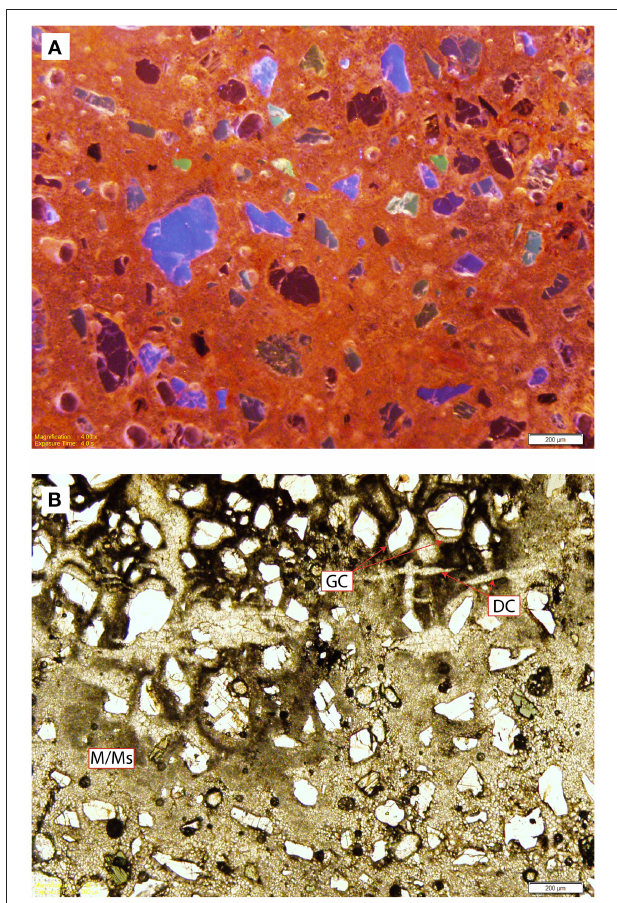
FIGURE 10 | Results of the thin section analysis of rhizoliths from LpM4. (A) Cathodoluminescence microscopy of a rhizolith from Unit 26, showing uniform to patchy luminescence. (B) Plane-polarized light microscope image of a rhizolith from Unit 26, showing micritic to microsparry calcite (M/Ms), complex desiccation cracks infilled with equant calcite crystals (DC), and radial grain coatings